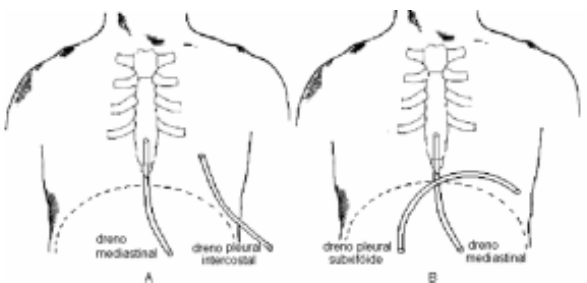
Fig.1 - Demonstração da localização dos drenos pleurais. A = dreno pleural na região intercostal esquerda (lateral) e B = dreno pleural na região subxifóide